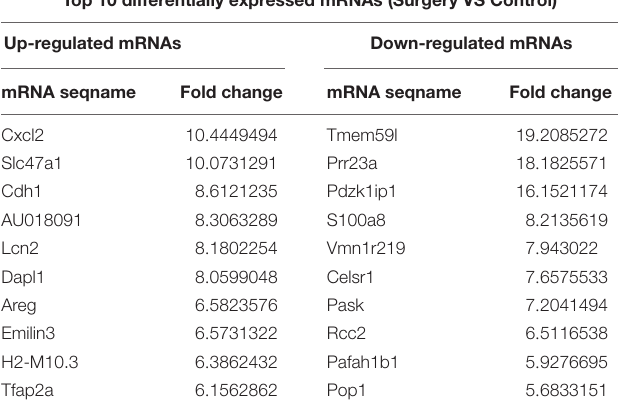
TABLE 2 | Top 10 differentially expressed mRNAs. Top 10 differentially expressed mRNAs (Surgery VS Control)